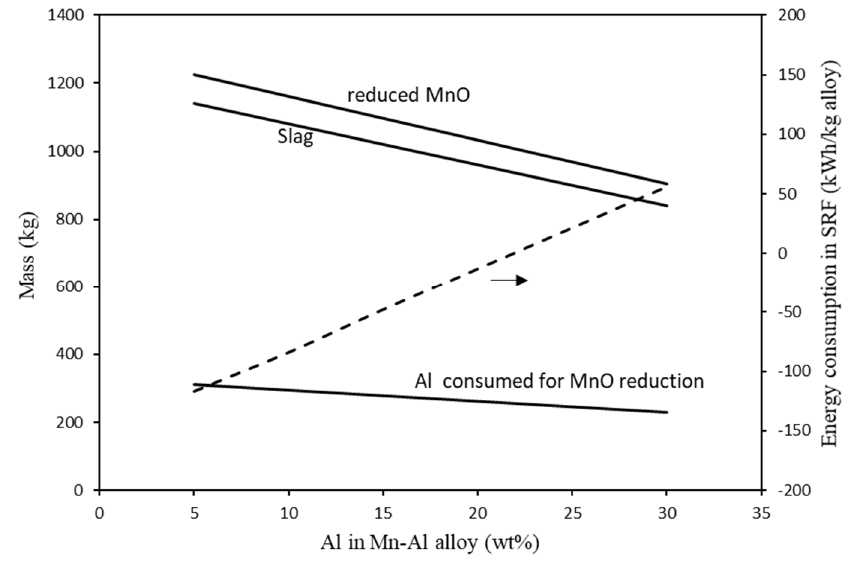
Figure 9. Masses of reduced MnO in PRR, produced slag in SRF, and consumed Al in SRF, and the energy consumption of SRF.